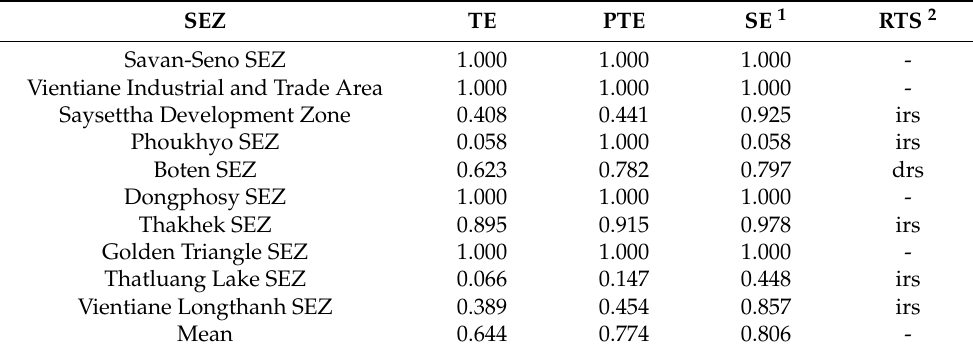
Table 3. Evaluation results of the land-use efficiency in Laos’ SEZs in 2018.